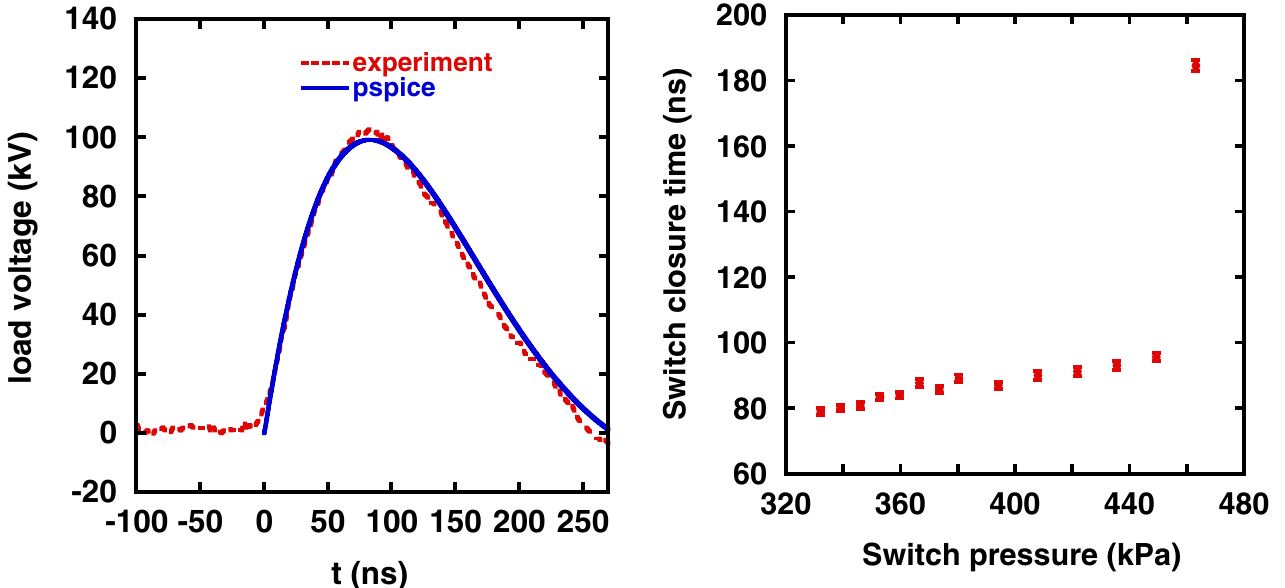
FIG. 14. (Color) Pictorial representation of the switch closure time (the time interval between the arrival of the trigger pulse on the switches and the start of the output pulse) as a function of the switch pressure.